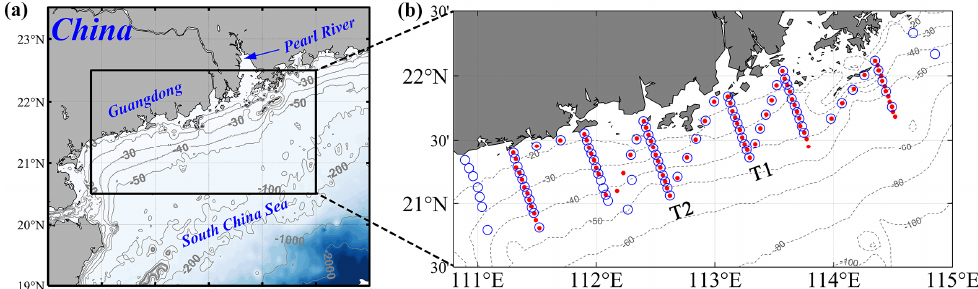
Figure 1. ( a ) Bathymetry of the study region (outlined with a black box) and its surrounding area. ( b ) Location of CTD sampling stations off the western Guangdong in spring 2016. Red dots and blue circles correspond to the April and May cruises, respectively. Gray contours are the isobaths.